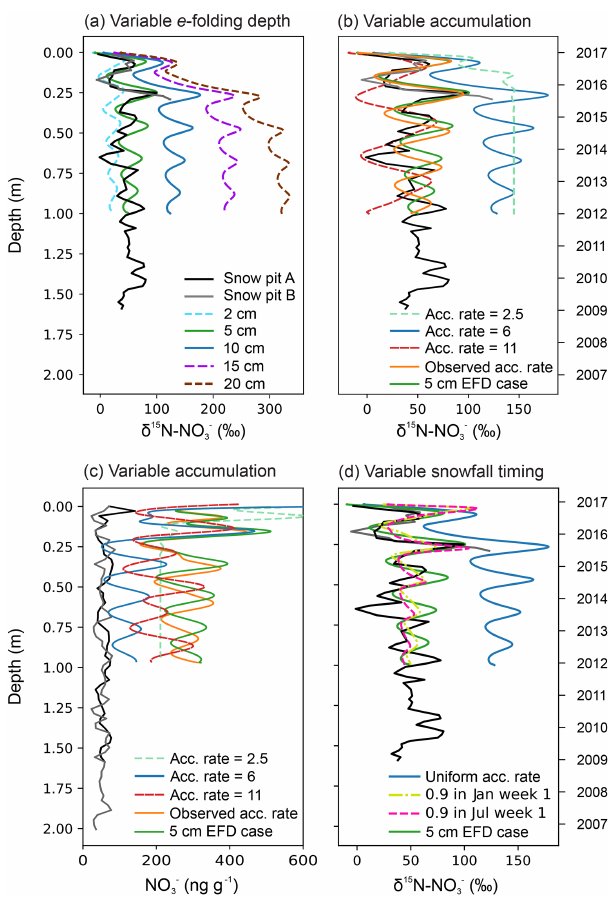
Figure 7. Snow pit depth profiles of observations and simulations from TRANSITS. (a) Sensitivity of δ 15 N-NO − to the e -folding 3 depth. (b) Sensitivity of δ 15 N-NO − and (c) sensitivity of NO − 3 3 mass concentration to the upper and lower bounds of accumula- tion rates observed over the last 1000 years at Dronning Maud Land (DML). Also shown are the depth profiles of the simulated δ 15 N- NO − values and NO − mass concentration using the observed accu- 3 3 mulation rate in our snow pits, i.e. variable accumulation rate with depth (orange line). The observed snow accumulation rate from the snow pits varied between 3.5 and 7.1cmyr − 1 w.e. (d) Sensitivity of δ 15 N-NO − to the timing of snow accumulation. In each panel, blue 3 is the base case simulation and green is the 5cm EFD case simula- tion, which we refer to throughout the study. Note that the nominal date refers to the base case